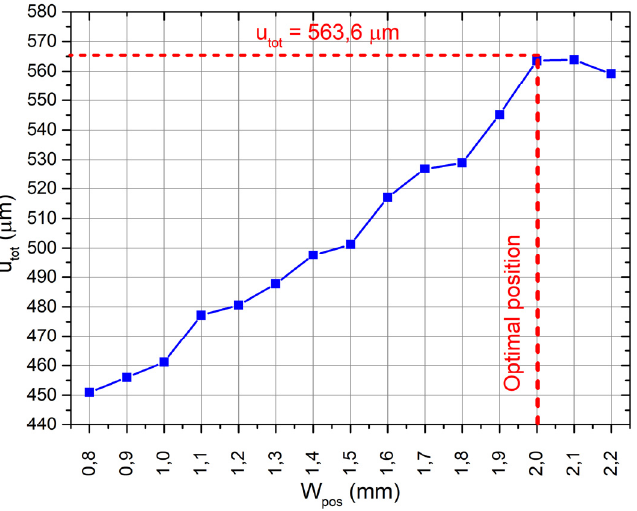
Figure 5. The plot of objective function of sphere position.